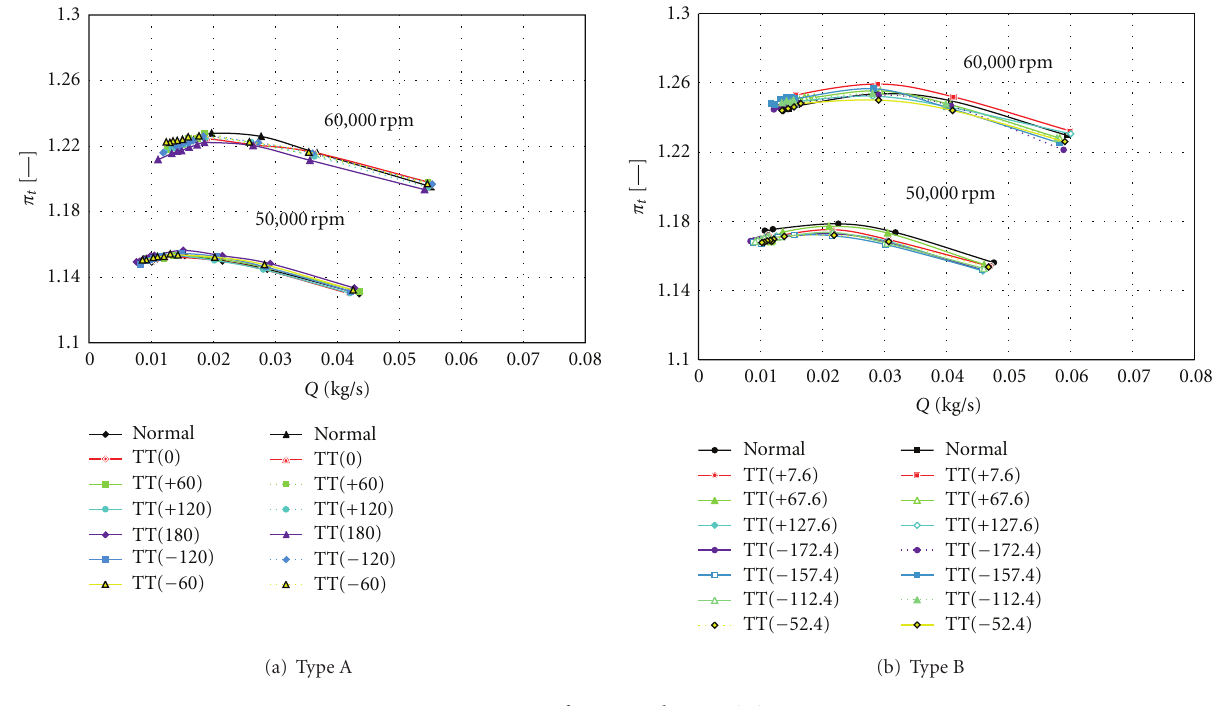
Figure 5: Performance characteristics.